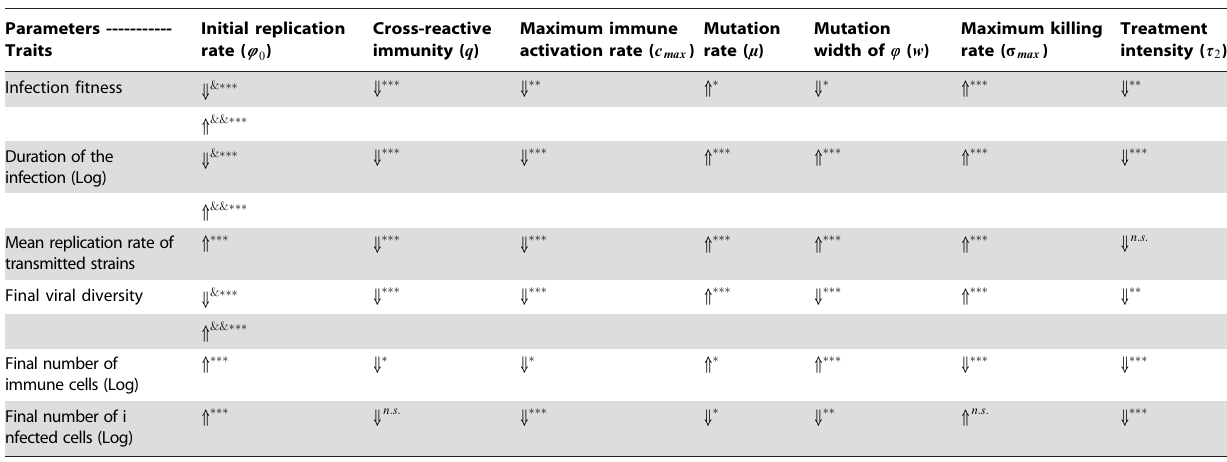
Table 2. Influence of model parameters and of the initial replication rate on infection life-history traits.